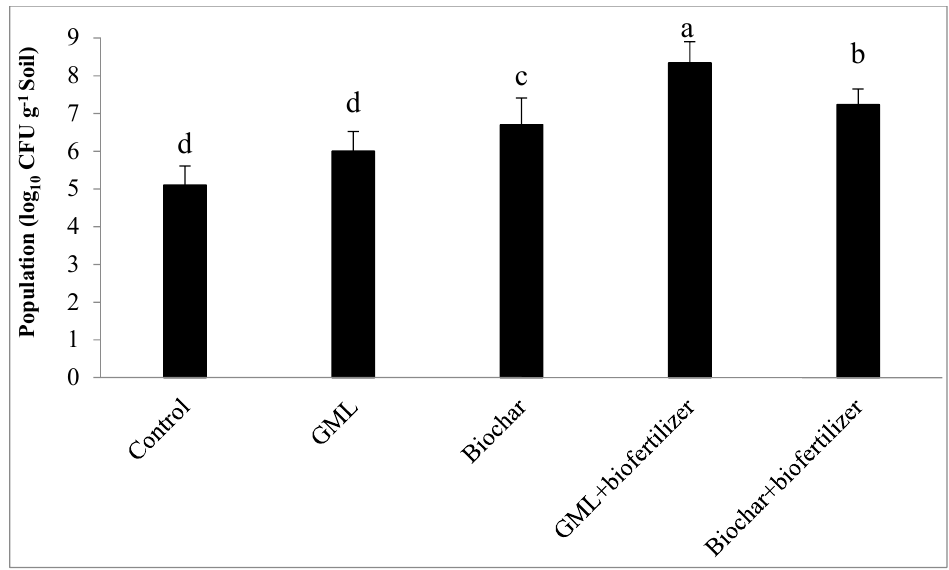
Figure 2. Effects of applying amendments on bacterial population in the soil. Figure 2. E ff ects of applying amendments on bacterial population in the soil.